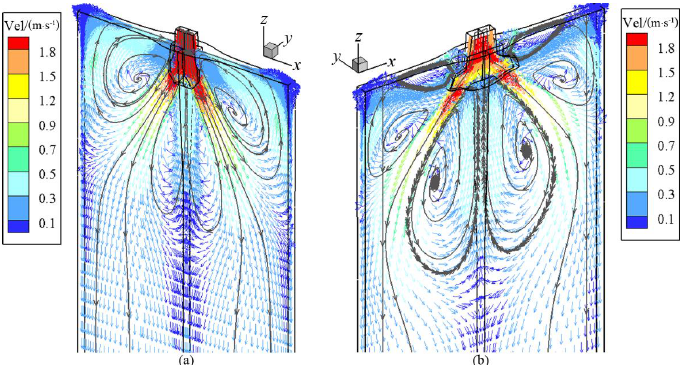
Figure 12. Characteristics of molten steel flow field in the mold: ( a ) CSP mold and ( b ) FTSR mold.